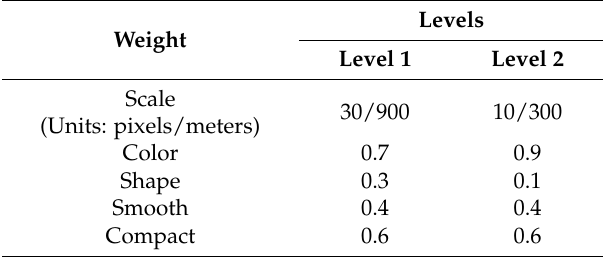
Table 1. Multi-resolution segmentation parameters used in this